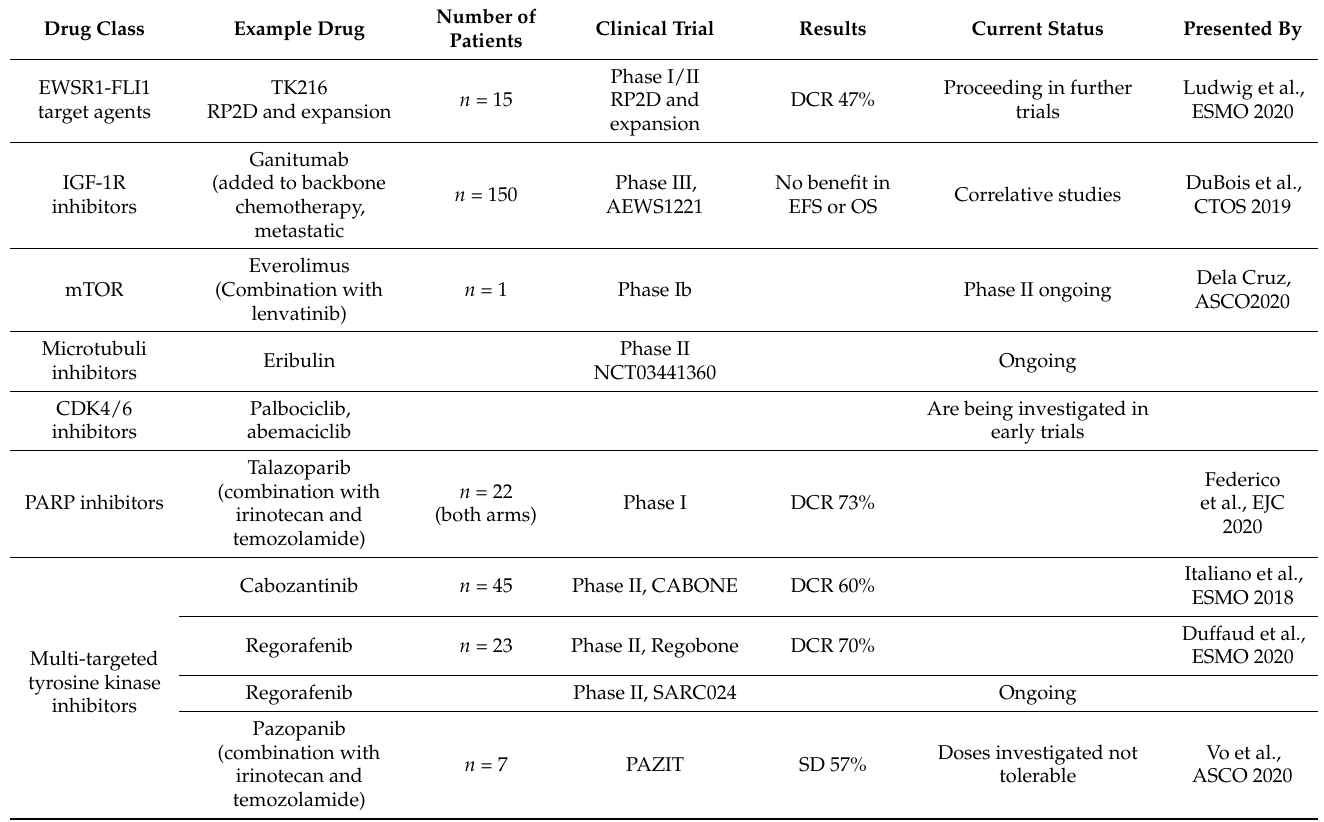
Table 1. Selected examples of ongoing, or recently completed, trials investigating novel therapies for metastatic ES. Drug